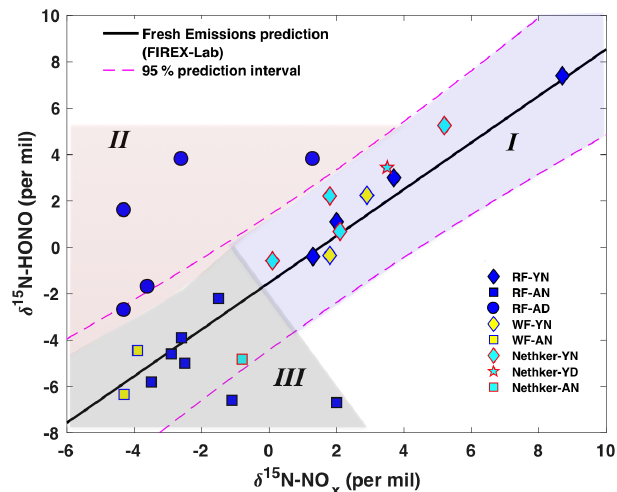
Figure 4. Relationship between wildfire-derived δ 15 N-HONO and δ 15 N-NO x . Samples from plumes of three wildfires including Rab- bit Foot fire (RF; 2018), Williams Flats fire (WF; 2019) and Nethker fire (2019) are shown as different colors. Different symbols indicate different smoke conditions including young nighttime smoke (YN), young daytime smoke (YD), aged nighttime smoke (AN) and aged daytime smoke (AD). Note that the mixed smoke samples displayed in Fig. 2 are not shown here due to their large uncertainty. The solid black line ( δ 15 N-HONO = 1.01 δ 15 N-NO x − 1 . 52; R 2 = 0 . 89, p< 0 . 001) is derived from lab-controlled burning emissions during the 2016 FIREX fire lab study (Chai et al., 2019) and within the 95% confidence interval (dashed magenta lines) predicts much of the field-based δ 15 N-HONO versus δ 15 N-NO x . The field data are further grouped into three regimes – young smoke in both day and night ( I , light purple shading), aged daytime smoke ( II , pink shad- ing) and aged nighttime smoke ( III , gray shading) based upon the δ 18 O-HONO